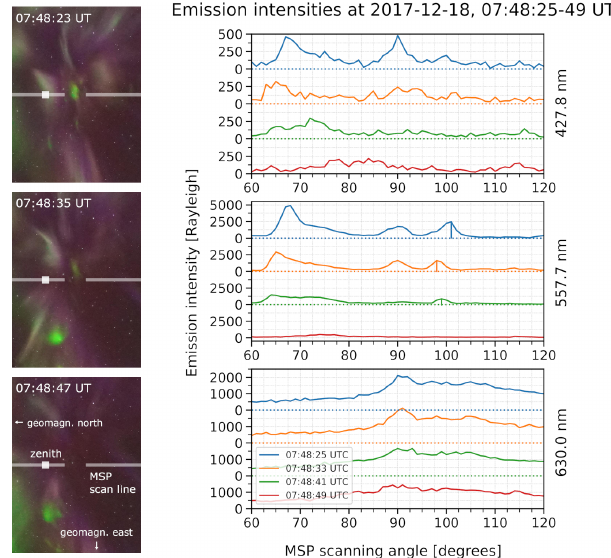
Figure 4. Comparison of consecutive cropped ASC images and MSP line scans for a FAE moving through the MSP scan line on 18 December 2017 between 07:48:23–47UTC. The FAE signatures are marked with vertical lines in the green channel (557.7nm). The MSP scan line (1 ◦ width) is drawn on the ASC images in grey. A grey square marks the geographic zenith in the centre of the ASC images. Credit: ASC images provided by the